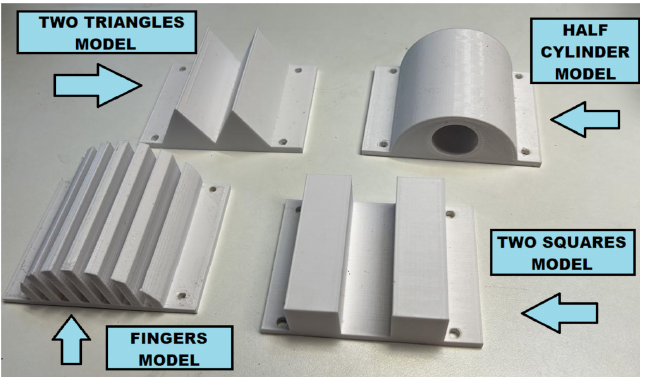
Figure 4. Models with different shapes and sizes are used as phantoms to evaluate the 3D Immersion Scanner’s ability to capture and reconstruct different types of objects.